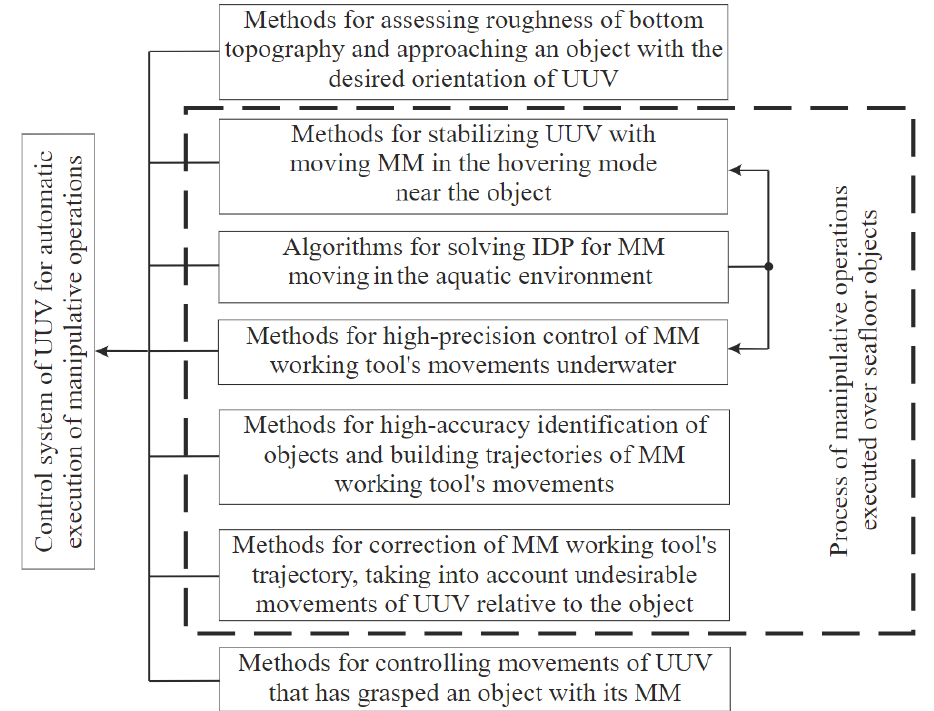
Figure 1. Block diagram of a multilevel control system of UUV for automated manipulative opera- tions.